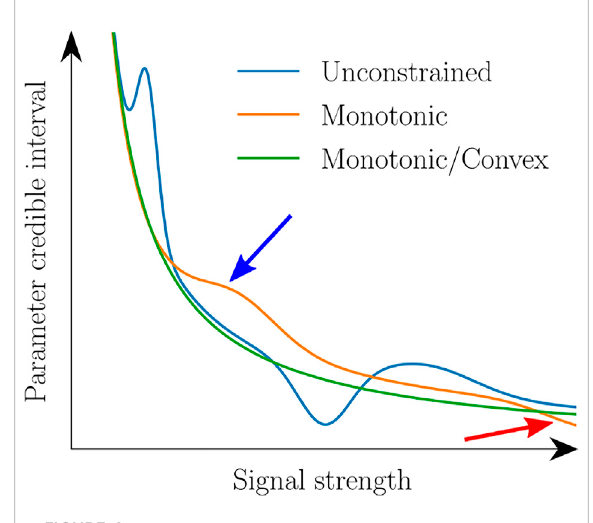
FIGURE 4 Comparison of possible regression models for predicting a model parameter credible interval as a function of the signal strength. An unconstrained model (blue) allows an ambiguous relationship that potentially predicts the same credible interval for different signal strengths. A monotonic model (orange) resolves this ambiguity but does not ensure that the credible interval decreases faster for smaller than higher signal strength. This can result in almost step-like functions (cf. Blue arrow) and nonasymptotic behavior (red arrow). These issues can again be avoided by functions that are both monotonicand convex